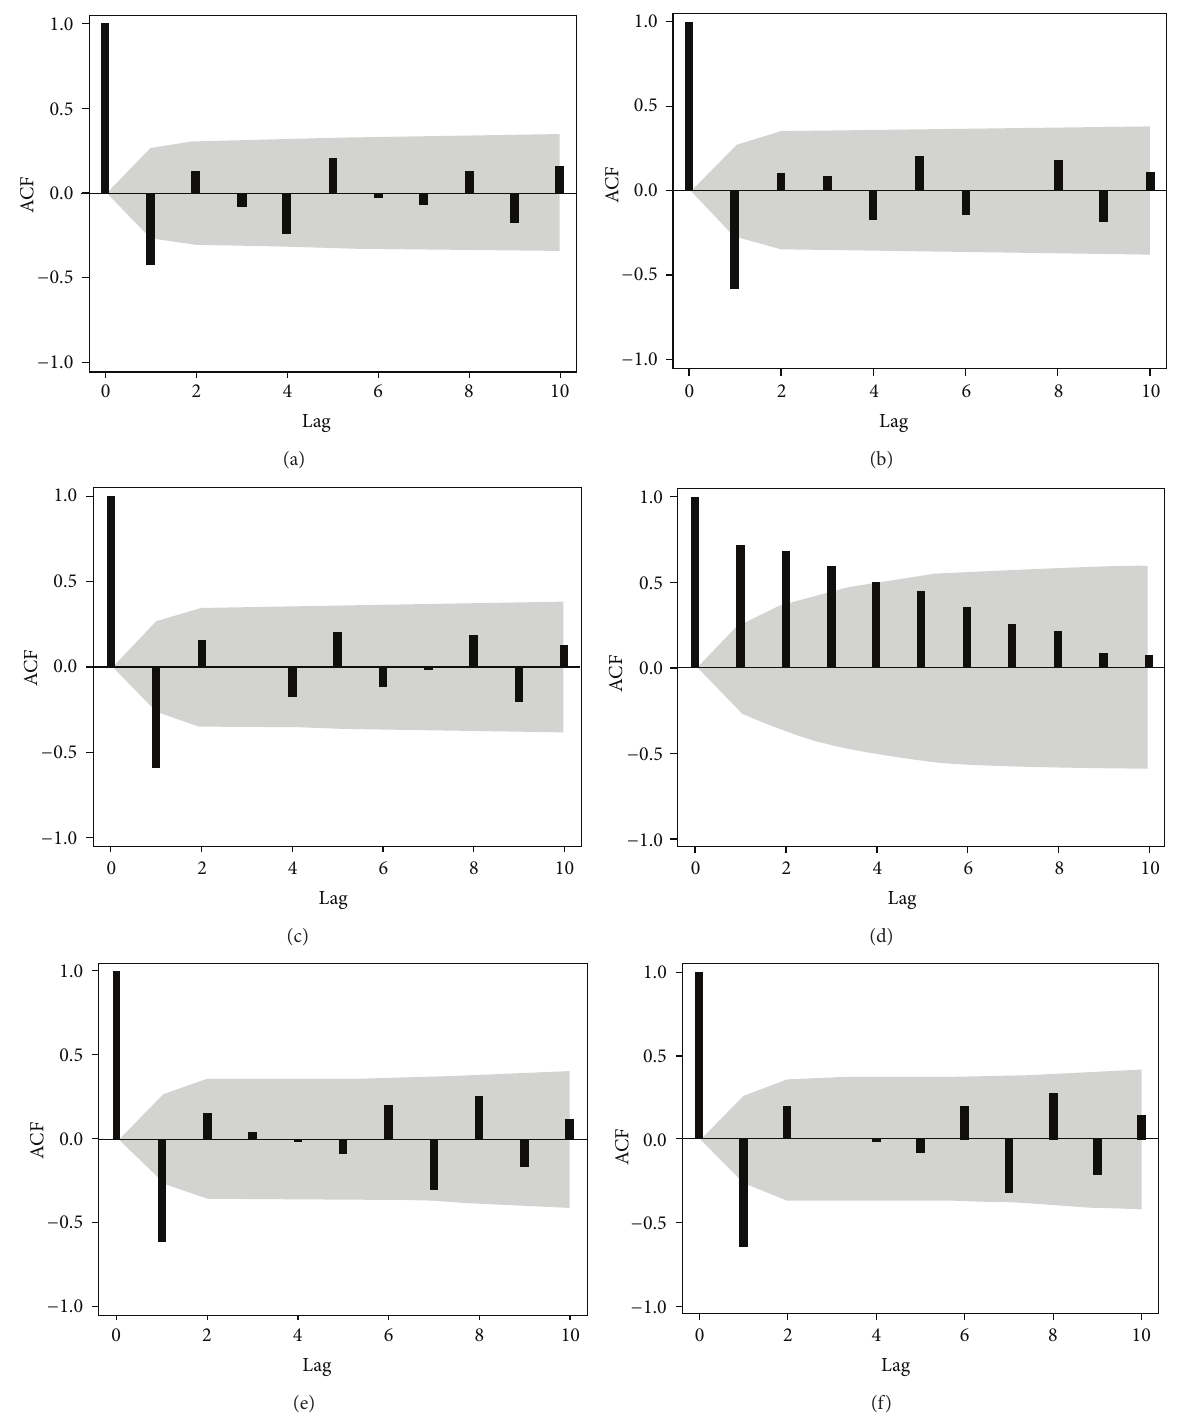
Figure 2: Autocorrelation function (ACF) for area, productivity, and production in Odisha and India. (a) Area (million hectare) in India; (b) productivity (kgha −1 ) in India; (c) production (million ton) in India; (d) area (million hectare) in Odisha; (e) productivity (kg ha −1 ) in Odisha; and (f) production (million ton) in Odisha (shaded areas in the plots are significant at 5%